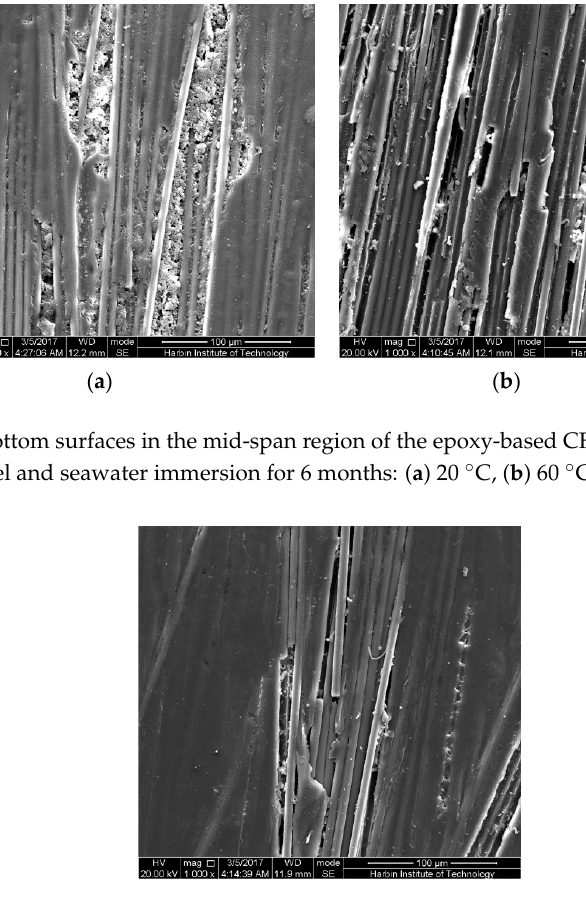
Figure 14. The bottom surfaces in the mid-span region of the epoxy-based CFRP samples after 6-month water immersion at 60 °C: ( a ) the unstrained samples, ( b ) samples under 58% strain level.